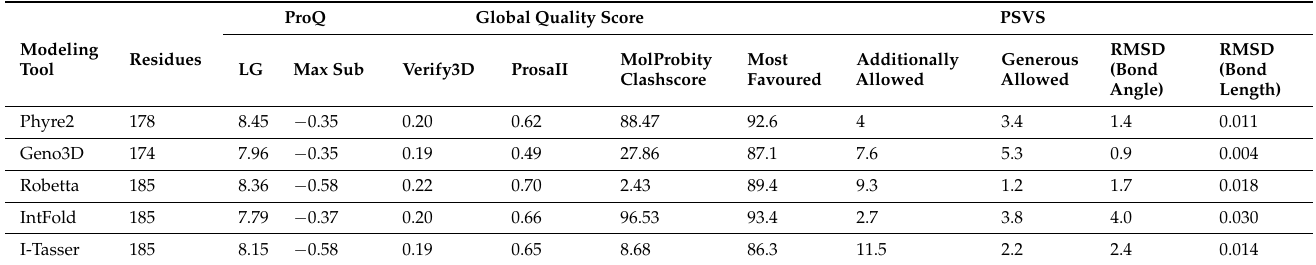
Table 3. Evaluation of ChrR from P. alcalifaciens homology-modeled structures.